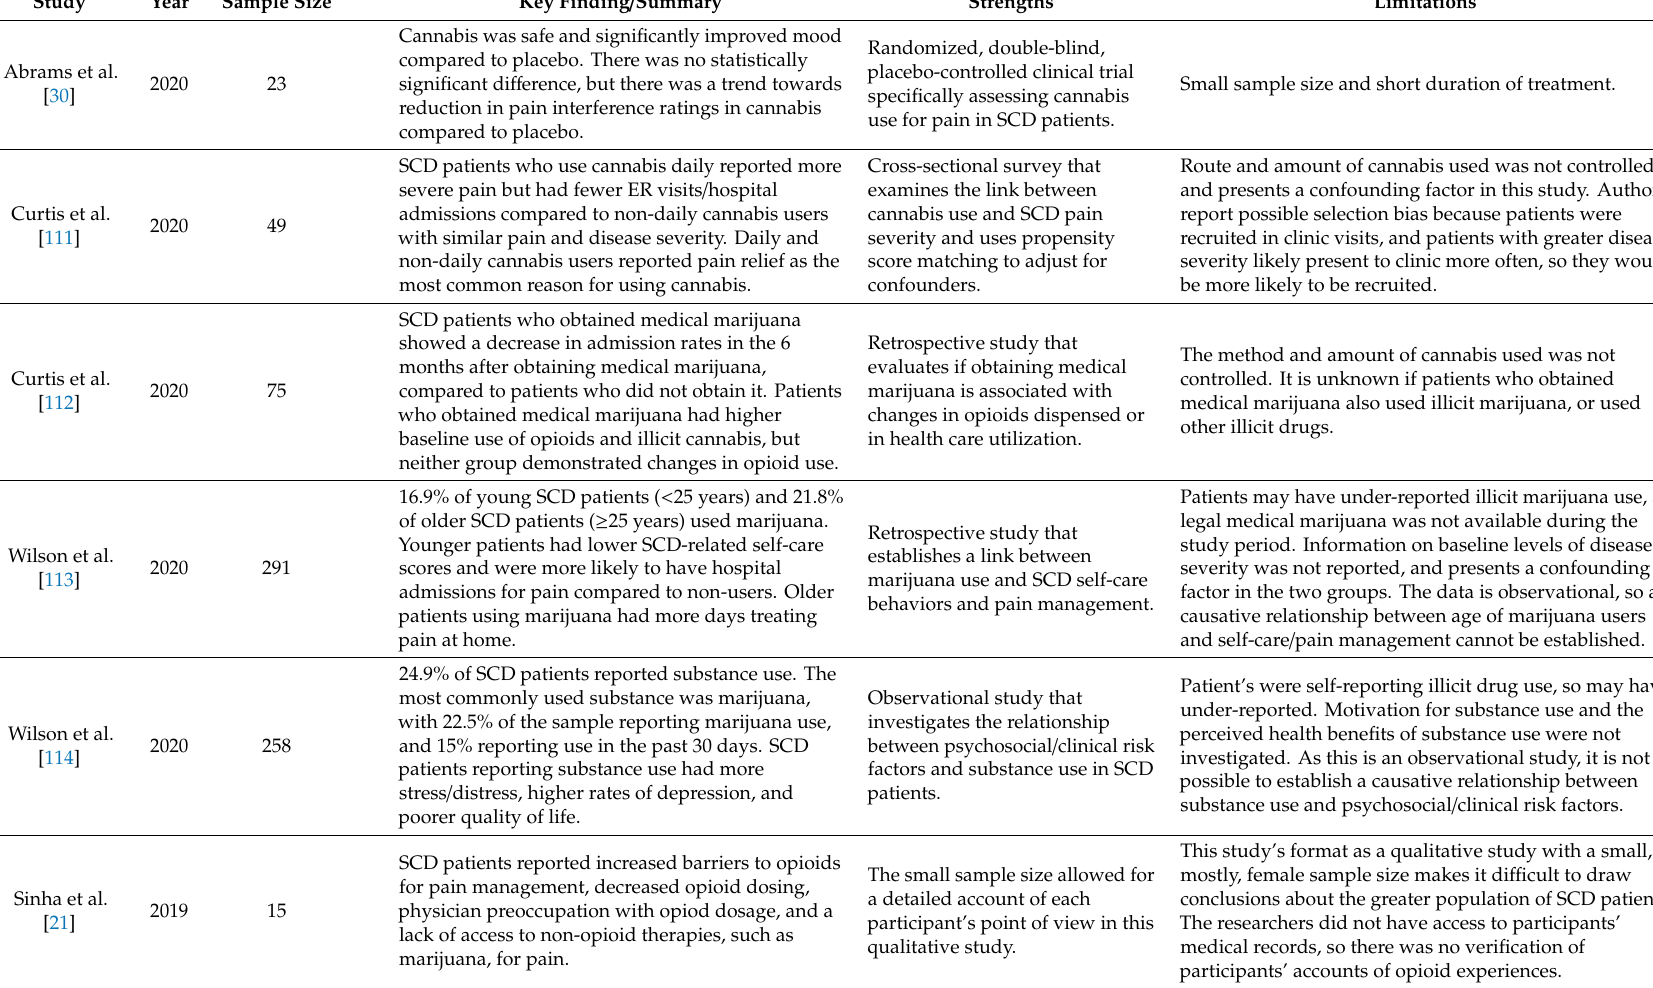
Table 1. Cannabis use in sickle cell